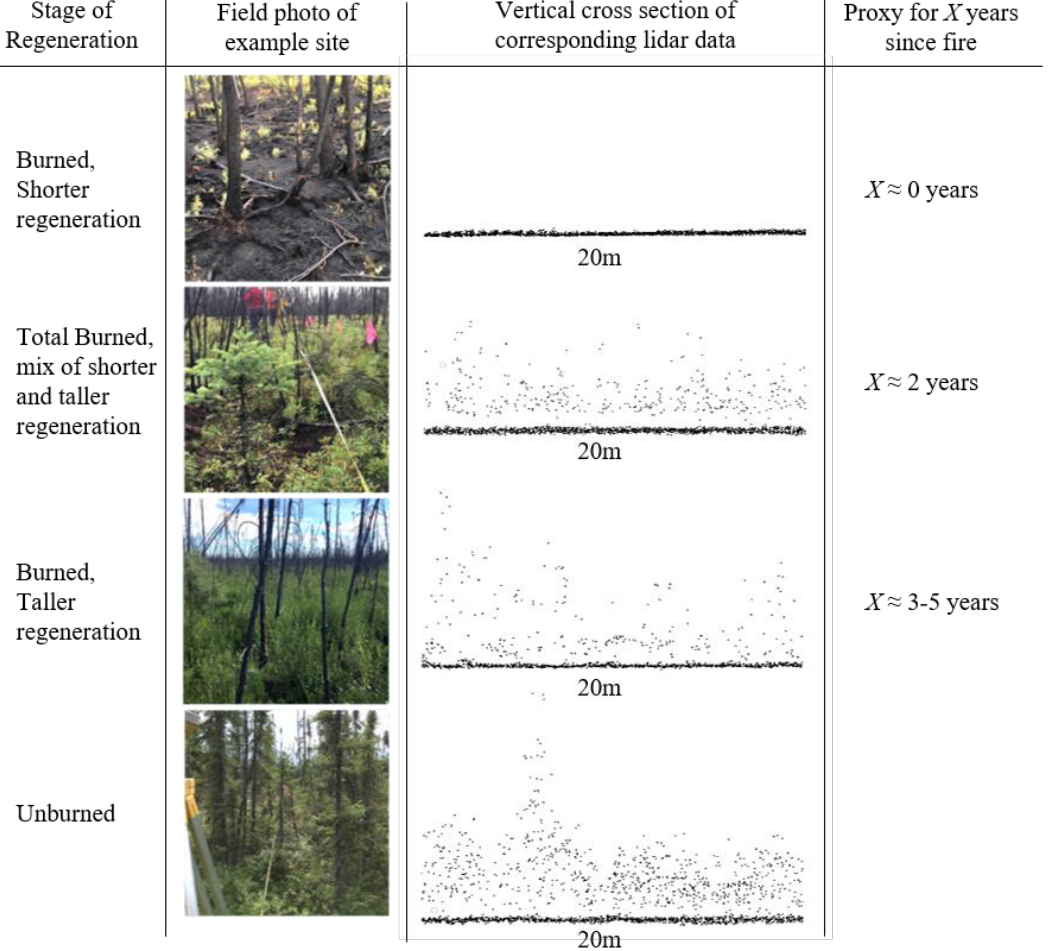
Figure 2. Four vegetation categories used to represent time since fire with field photos and lidar point clouds.